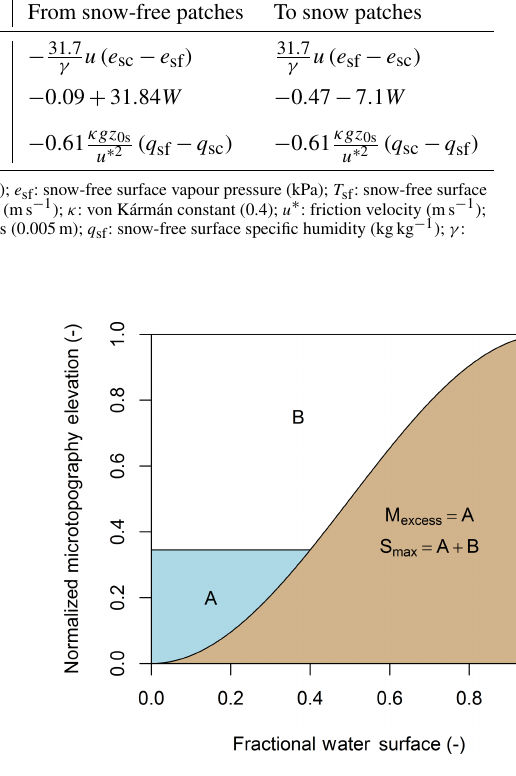
Figure 3. Conceptual water area–volume relationship diagram where a cross section of land surface microtopography (brown is soil and blue is water) is assumed to follow a sinusoidal